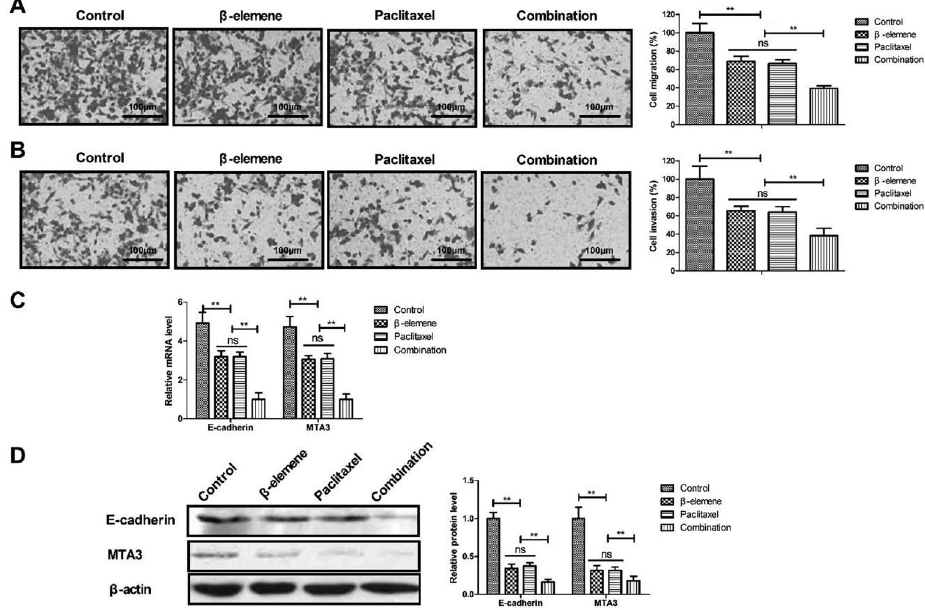
Figure 4. Effect of b -elemene + paclitaxel on migration ( A ) and invasion ( B ) of SKOV3 cells (magni fi cation bar, 100 m m). C and D , Relative E-cadherin and MTA3 mRNA ( C ) and protein ( D ) expression in SKOV3 cells after treatment with b -elemene and/or paclitaxel. Data are reported as means ± SD. **P o 0.01 (ANOVA followed by Tukey ’ s multiple comparison post hoc test). ns: not signi fi cant.